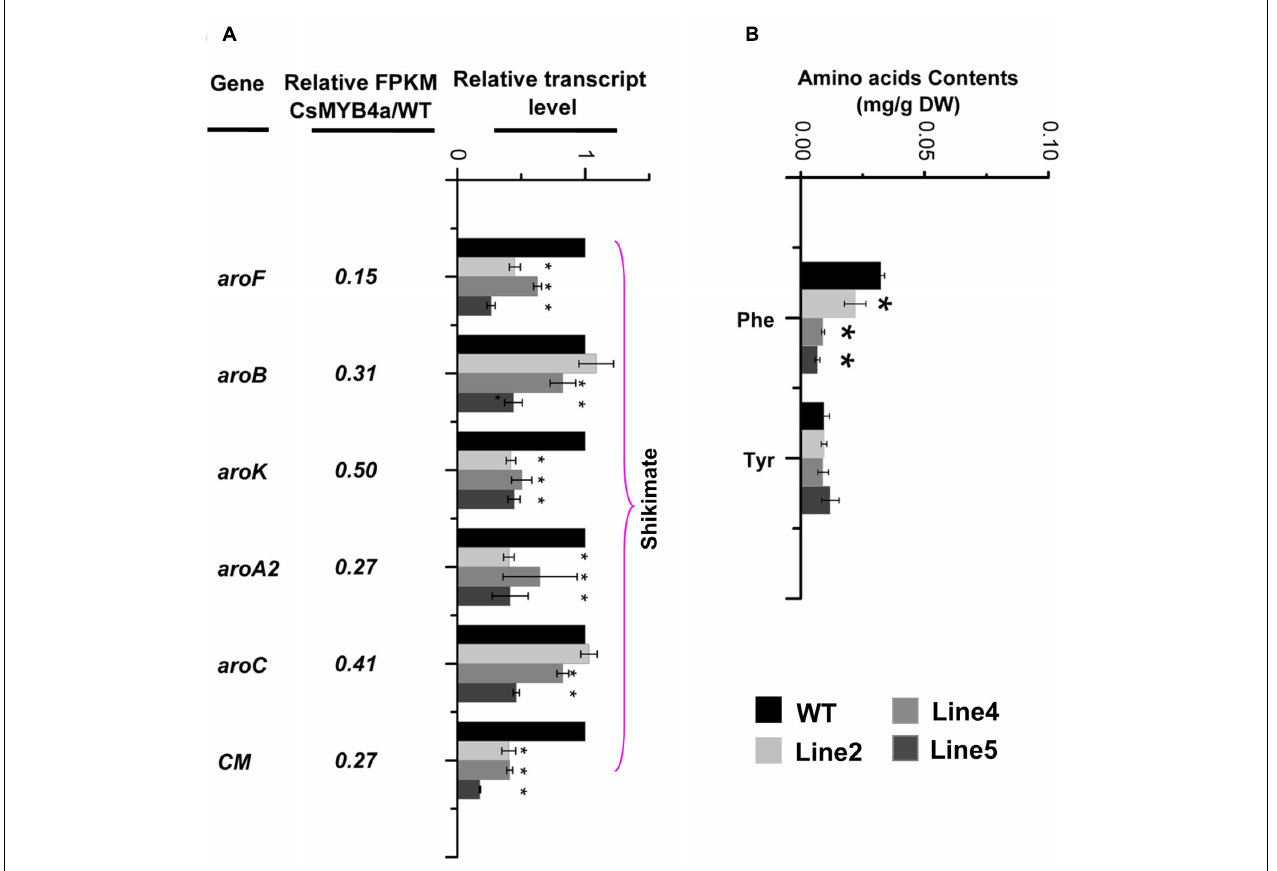
FIGURE 6 | CsMYB4a overexpression affects the transcriptional level of six shikimate pathway genes and amino acid levels. (A) Ratio values were obtained by dividing the RPKM value of each gene in CsMYB4a transgenic plants by the corresponding RPKM value in wild-type plants. qRT-PCR analysis of each gene in three different lines of transgenic plants and wild-type plants. (B) Level of different amino acids in wild-type and CsMYB4a transgenic tobacco plants. Values represent the mean ± SD ( n = 3). Asterisks on top of the bars indicate significant differences from the equivalent control ( ∗ P < 0.05, ∗∗ P < 0.01, ∗∗∗ P <